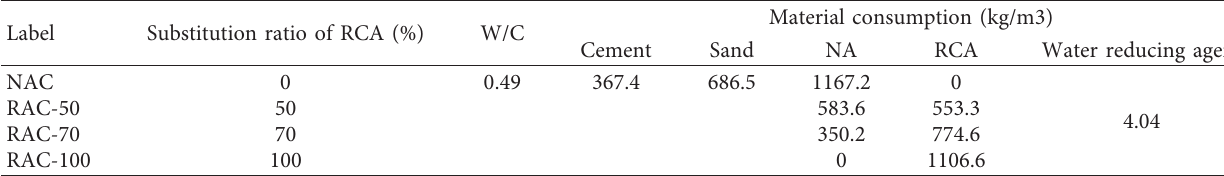
Table 2: Concrete consumption per unit volume.